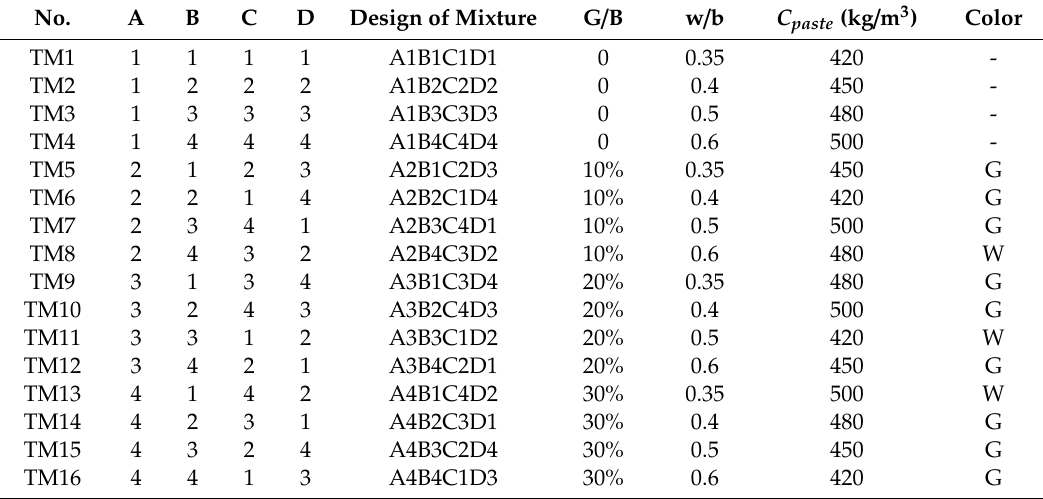
Table 6. Taguchi design mixture proportions of